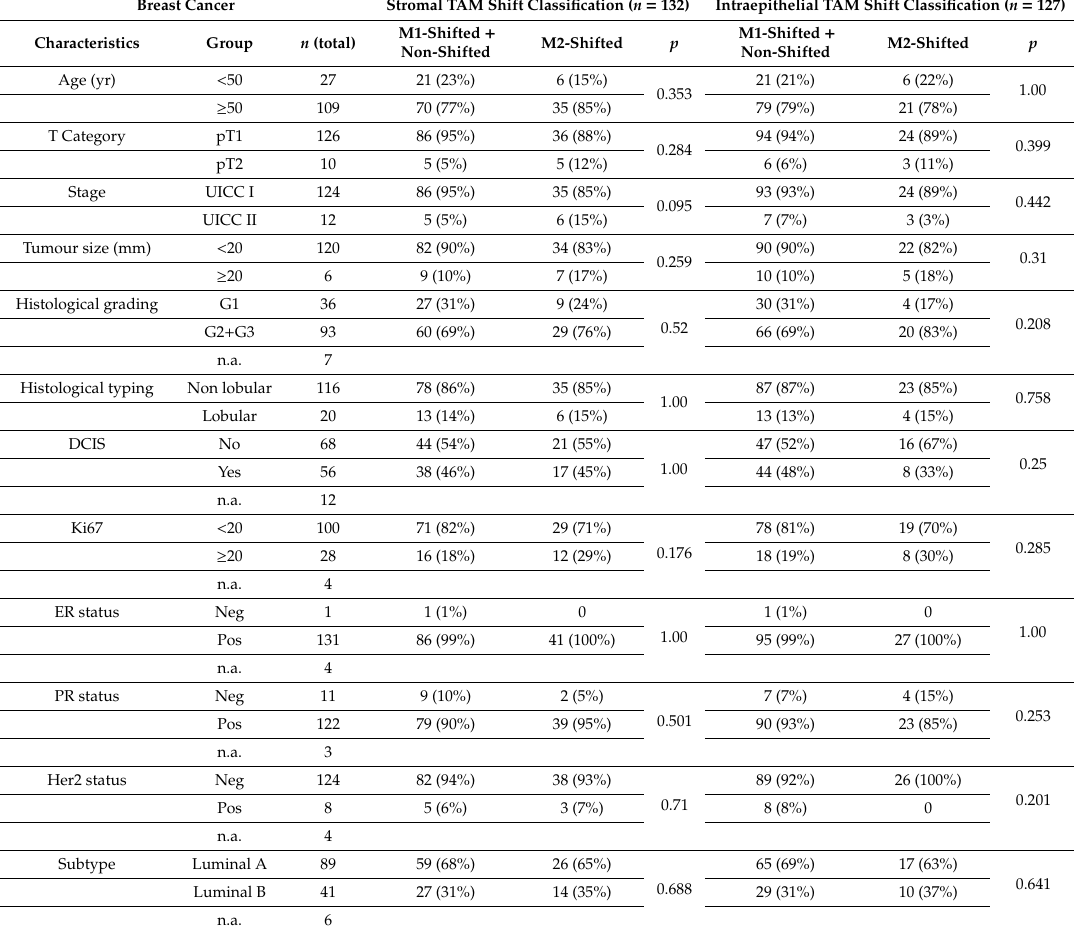
Table 5. Correlations between clinicopathological characteristics and macrophage shifts in both tumour compartments of invasive front samples. Breast Cancer Stromal TAM Shift Classification ( n =